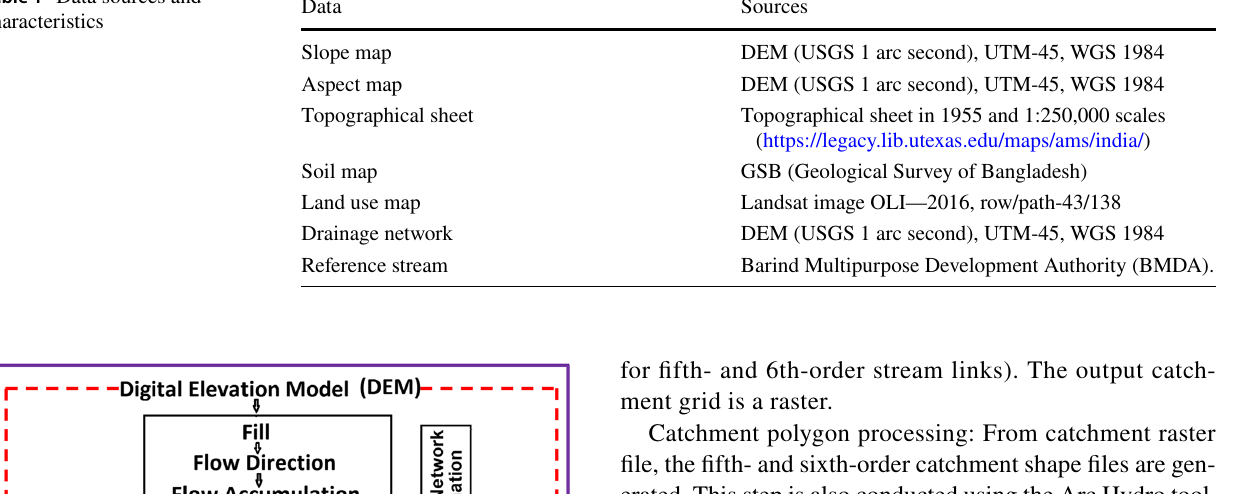
Table 1 Data sources and characteristics